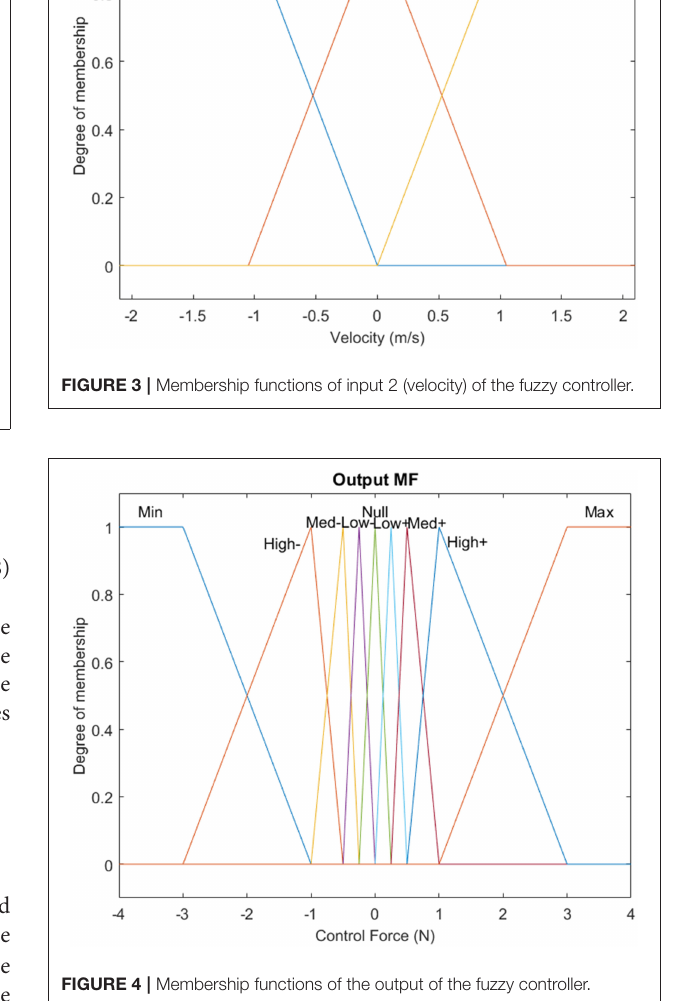
FIGURE 4 | Membership functions of the output of the fuzzy